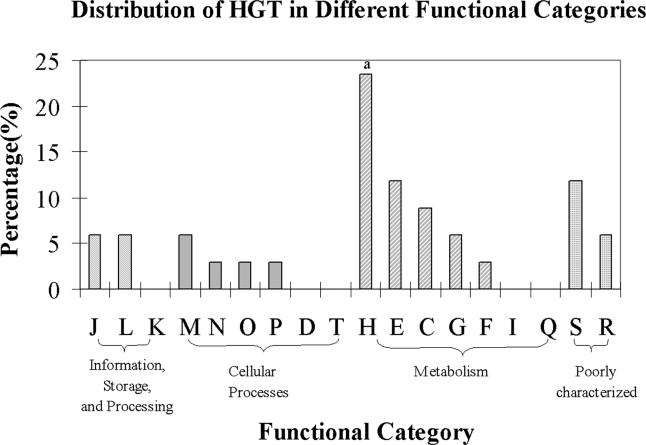
Distribution of Transferred Genes in Different Functional CategoriesFunctional category abbreviations can be found in Table 2. The percentage of transferred genes in coenzyme metabolism (H) is significantly high, based on Fisher's exact test.